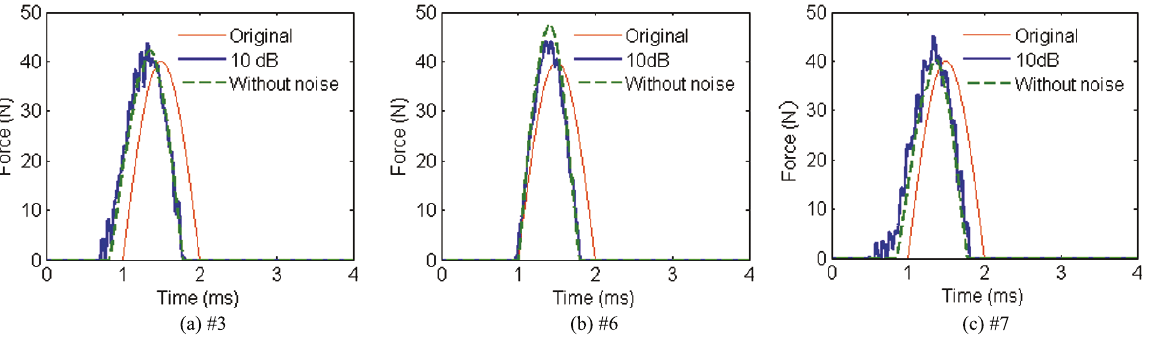
Fig. 8. Impact force time-history reconstructions with uniform distribution noise.